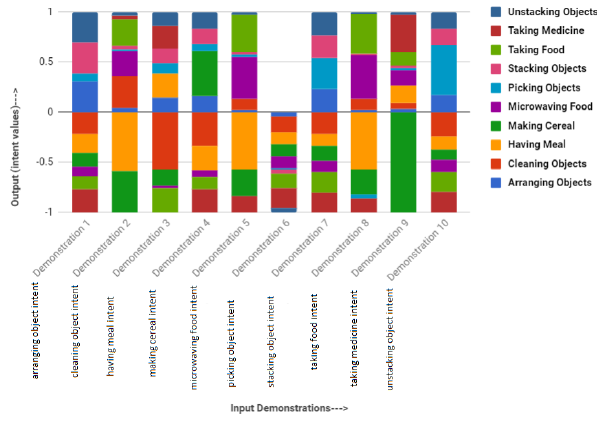
Figure 8: Performance over 10 categories of demonstrations.